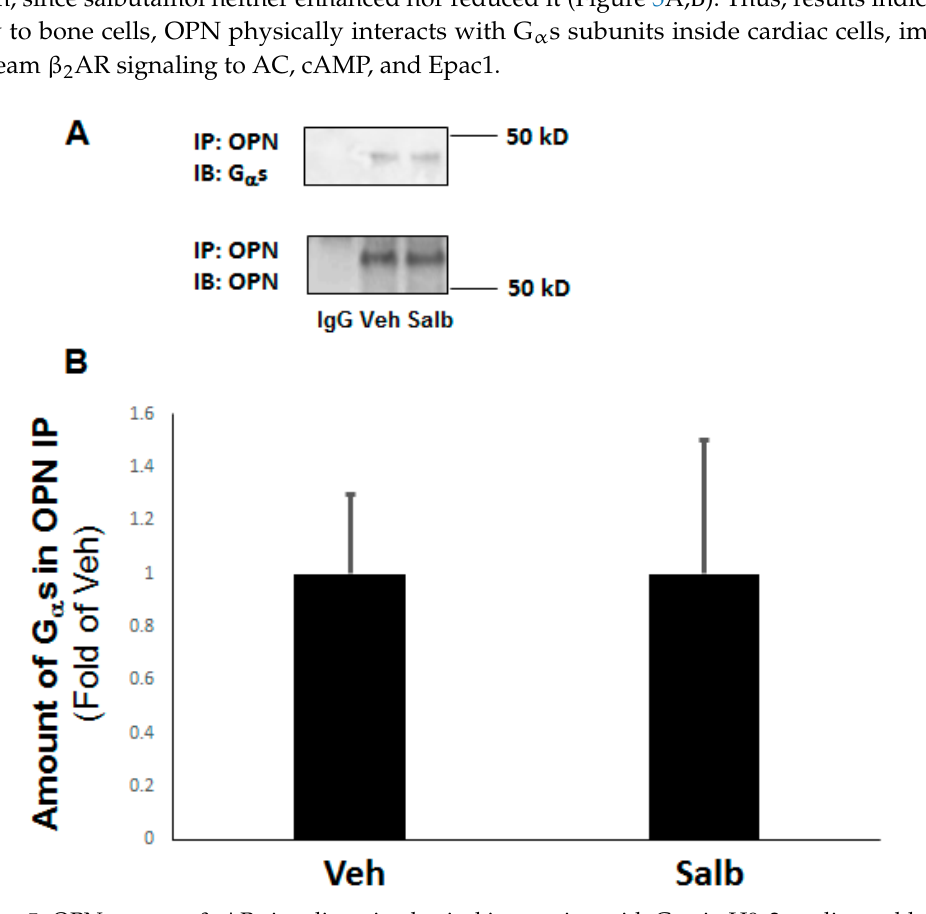
Figure 5. OPN opposes β 2 AR signaling via physical interaction with G α s in H9c2 cardiomyoblasts. Co-immunoprecipitation (co-IP) of OPN with G α s in native WT H9c2 cells treated with vehicle